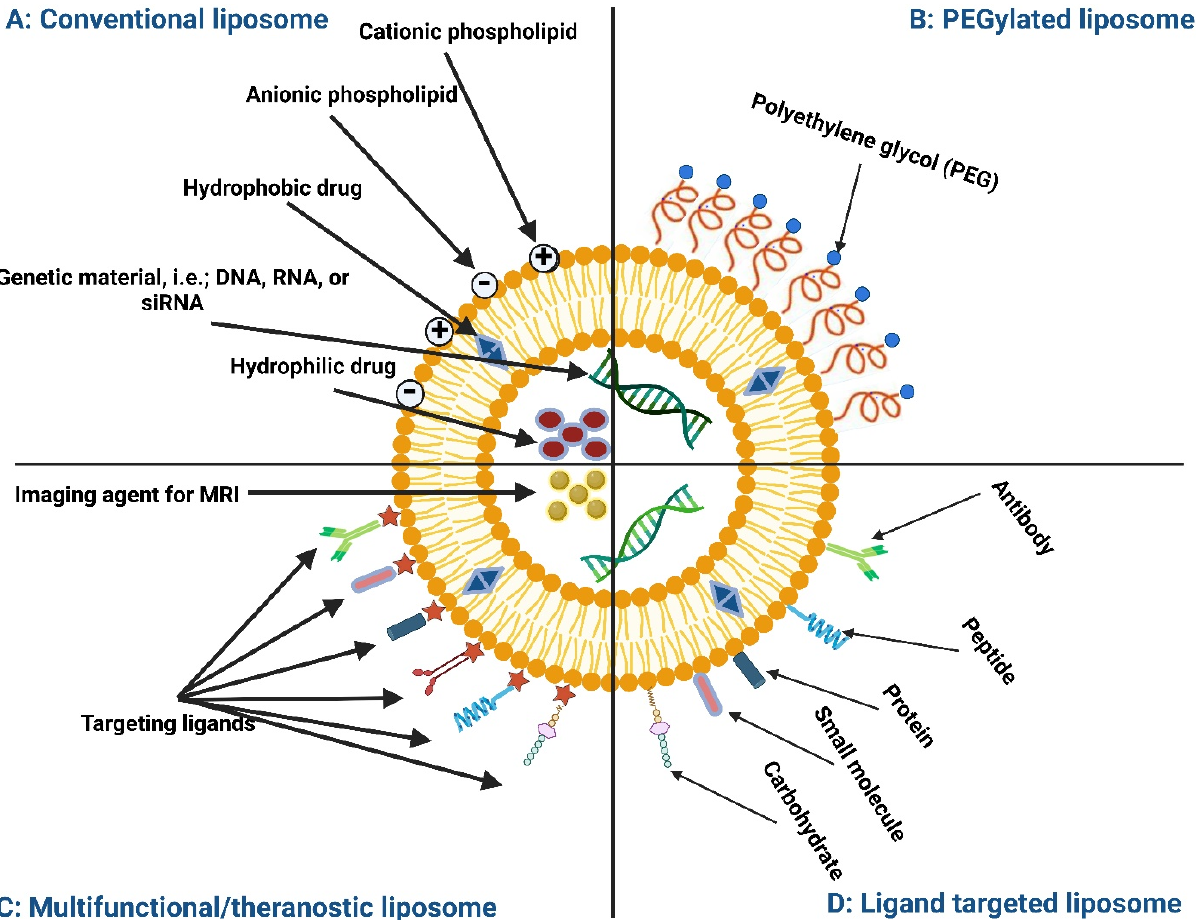
Figure 1. Liposome classification according to the surface modification strategy: ( A ) Conventional liposomes. ( B ) PEGylated/stealth liposomes. ( C ) Multifunctional/theranostic liposomes. ( D ) Ligand targeted liposomes.